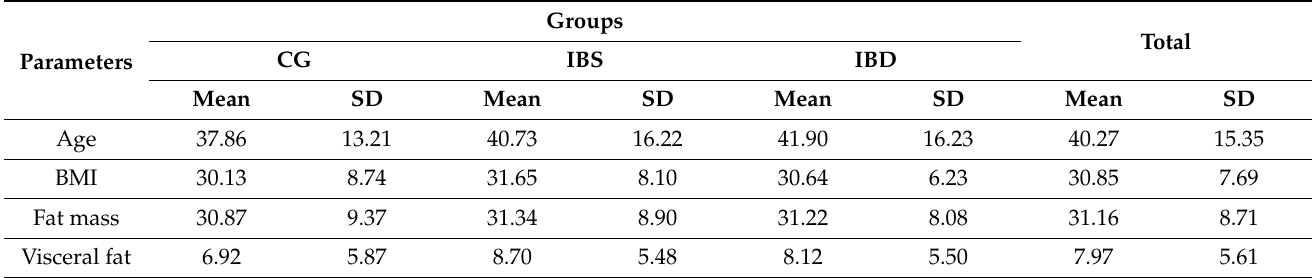
Table 2. Statistical description of baseline